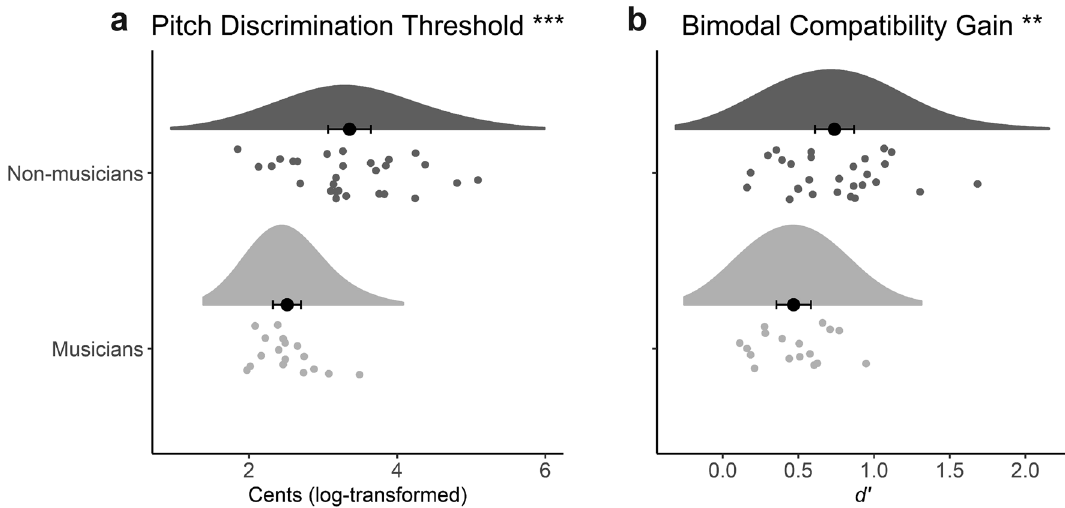
Figure 1. Means of the ( a ) log-transformed Pitch Discrimination Thresholds (PDT) and the ( b ) Bimodal Compatibility Gain (BCG), (i.e. crossmodally matching condition minus no visual cue condition) are significantly higher in non-musicians than in musicians. Error bars represent 95% confidence intervals. Asterisks indicate significant differences between groups, *** p < 0.001, ** p <